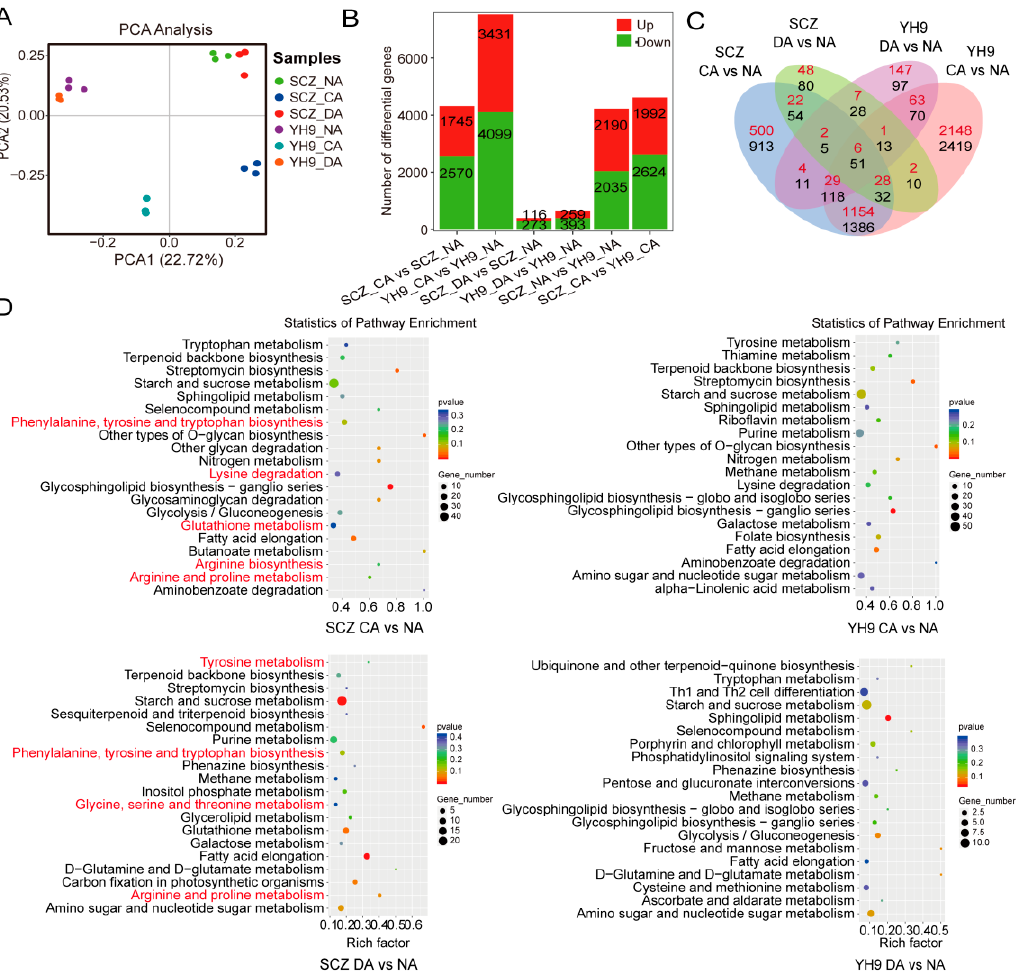
Figure 3. Overview of transcriptomic analysis. ( A ) Principal component analysis of RNA-Seq data of tea plants. ( B ) Number of up-regulated and down-regulated differentially expressed genes (DEGs) in SCZ and YH9. ( C ) Venn diagrams of DEGs between two tea varieties during cold acclimation. Red represents up-regulation and green represents down-regulation. ( D ) KEGG pathway impacted at CA stage in SCZ and YH9.